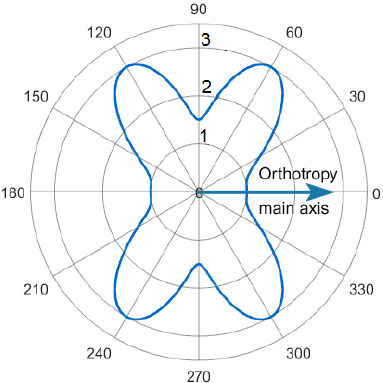
Figure 6. The angular distribution of relative dimensionless attenuation coefficient for the anti-symmetric A0 waves propagating from the center of the orthotropic CFRP panel [20].